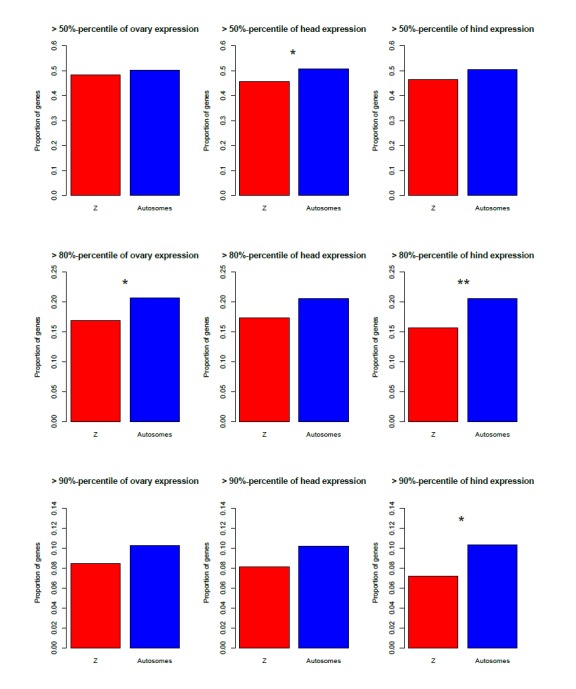
Depletion of the Z-chromosome for genes highly expressed in three female tissues (ovary, head, hind), for three different expression cut-offs.*p<0.05 **p<0.01, Pearson'ʹs Chi-squared test with Yates' continuity correction.